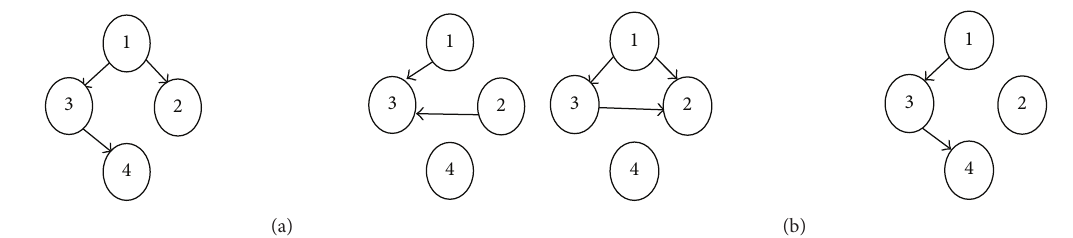
Figure 1: (a) Two GRN structures before inference. (b) GRN structures after evolvement during the inference process, whereby arcs are swapped between the nodes 3-4 and